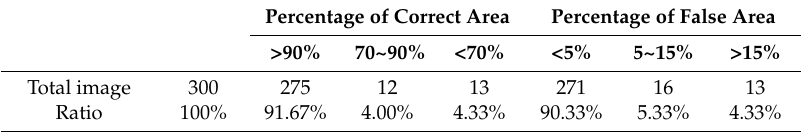
Figure 10. The successful detection results. ( a , d ) Fruit area; ( b , e ) the region of interest (red box) Table 3. Confusion matrix of segmentation result. and the Hough detection; ( c , f ) picking-point calculation. Table 2. Statistical results of grape-detection experiment. Table 3. Confusion matrix of segmentation result.